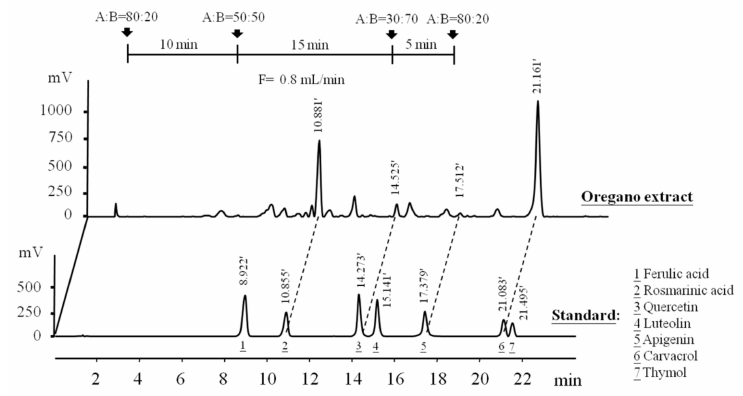
Figure 1. High-performance liquid chromatography (HPLC) chromatograms of phenolic compounds in ethanolic extracts of oregano leaf (EOE). Detection was at 280 nm. Peaks of a mixture known standards are ferulic acid (1), rosmarinic acid (2), quercetin (3), luteolin (4), apigenin (5), carvacrol (6), and (7) thymol. Retention times (min) of phenolic peaks of EOE were shown.